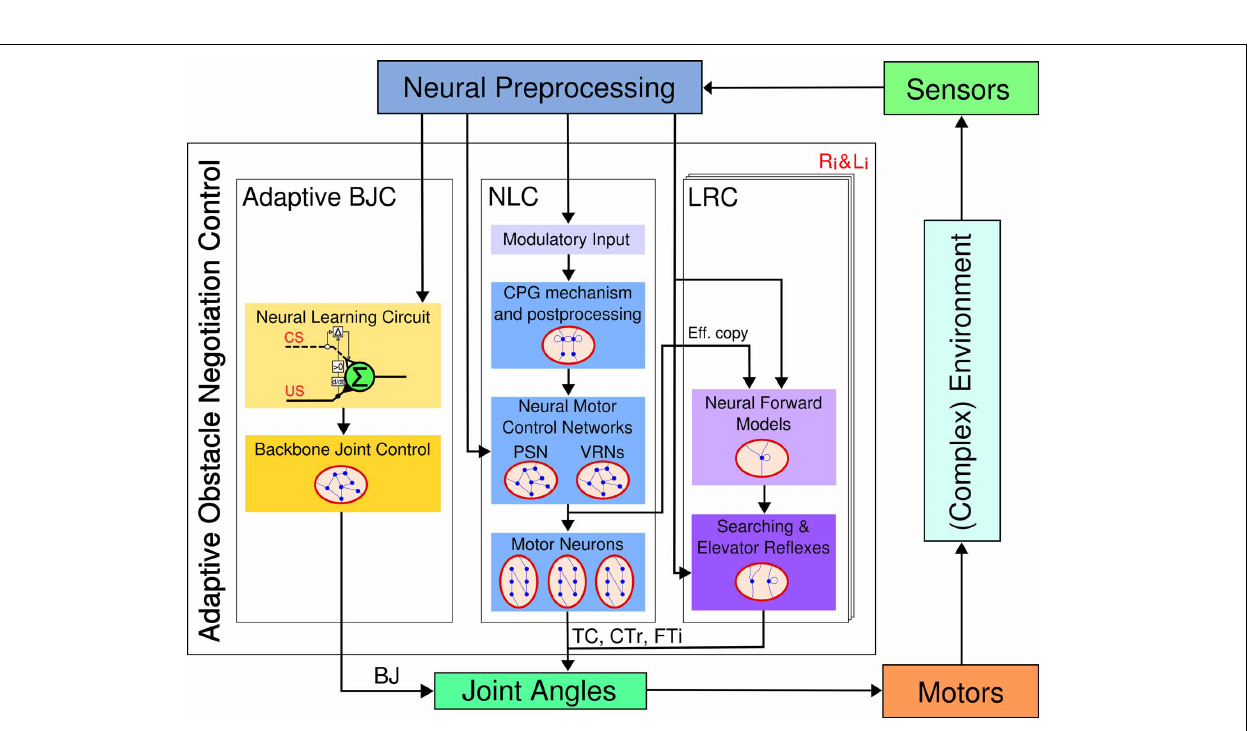
FIGURE 2 | Embodied closed-loop neural control architecture for adaptive obstacle negotiation behavior. It is composed of an adaptive backbone joint control (BJC), a neural locomotion control (NLC), and six local